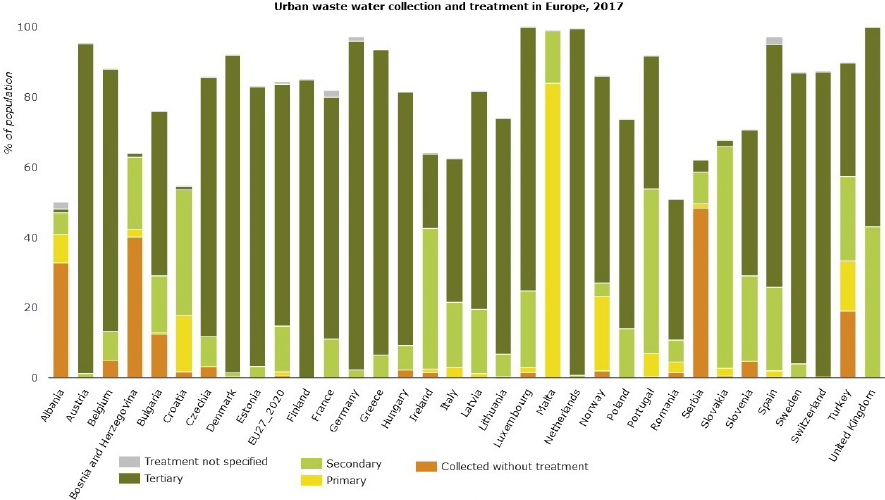
Figure 5. Urban waste water collection and treatment in Europe, 2017 [56].